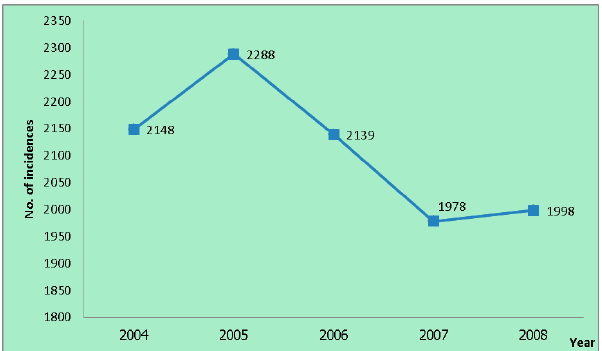
Figure 2. Number of tuberculosis (TB) incidences from 2004 to 2008.